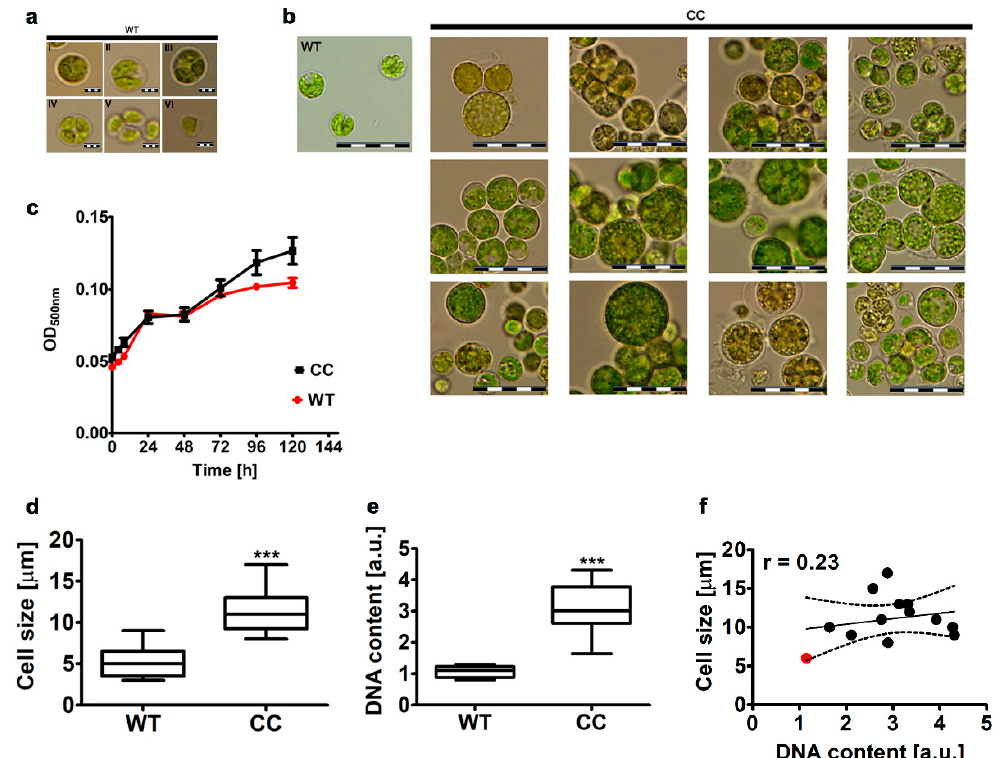
Figure 1. Colchicine and cytochalasin B-mediated e ff ect on cell morphology, growth rate, cell size and DNA content in the microalga Planktochlorella nurekis . ( a ) Morphological features of wild type (WT) cells. Representative microphotographs are presented. Scale bars 3 µ m, objective 100 × . Coccoidal forms (I,II) as well as autospores in the autosporangium (III–VI) are shown. ( b ) A comparison between morphological features of WT cells and twelve CC-treated clones. Representative microphotographs are presented. Scale bars 20 µ m, objective 100 × . ( c ) Cell growth kinetics of WT cells (red) and CC-treated clones (black). Cell growth was monitored turbidimetrically at 500 nm in a microplate reader during a period of 120 h. Bars indicate SD, n = 3. ( d ) Morphometric analysis of cell size (diameter in µ m) using a light microscopy. Box and whisker plots are shown (mean ± SD), n = 3, *** p < 0.001 compared to WT cells (ANOVA and Dunnett’s a posteriori test). ( e ) Fluorescence microscopy-based analysis of DNA content. DNA content of twelve CC-treated clones (CC) was compared to WT cells (WT). ImageJ software was used to analyze the nuclear DNA content. DNA content was expressed as arbitrary units [a.u.]. Box and whisker plots are shown (mean ± SD), n = 3, *** p < 0.001 compared to WT cells (ANOVA and Dunnett’s a posteriori test). ( f ) Correlation analysis between cell size and DNA content. Twelve CC-treated clones were considered (black dots). WT cells are denoted as a red dot. Results represent the mean from three independent experiments. The 95% confidence interval is shown. Correlation analysis of the data was performed using a Linear Correlation (Pearson r) test.